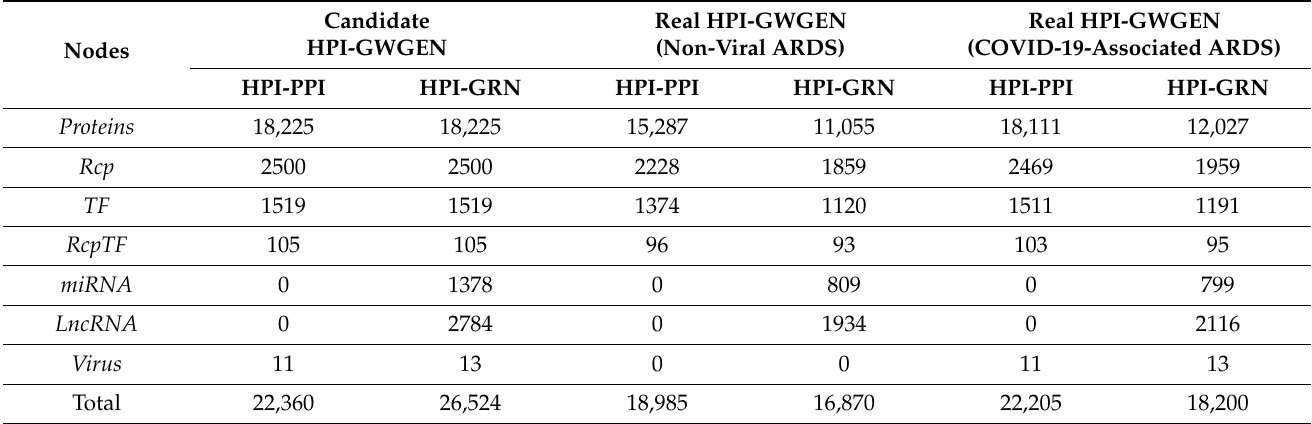
Table 2. Comparison of numbers of nodes in candidate HPI-GWGEN, real HPI-GWGEN of